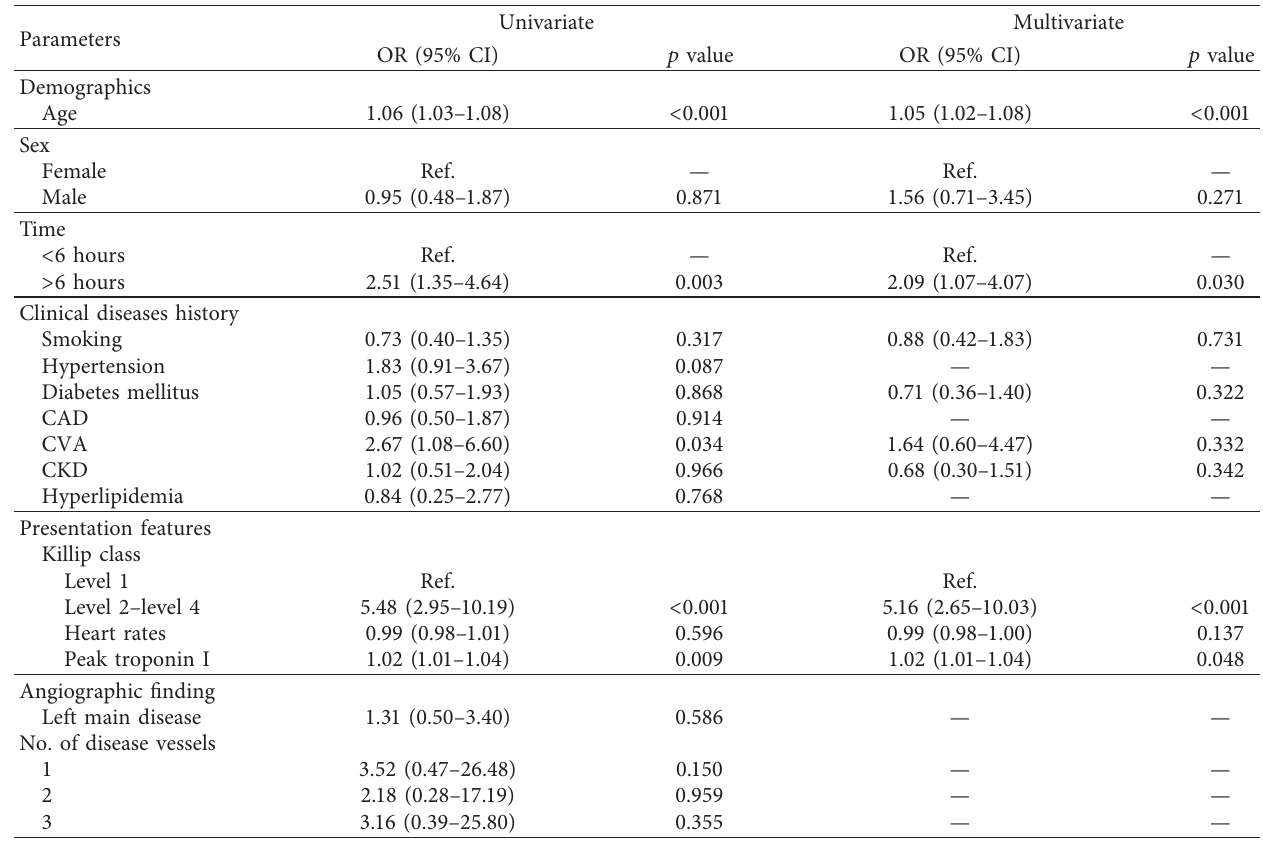
Table 3: Univariate and multivariate analysis for in-hospital MACE